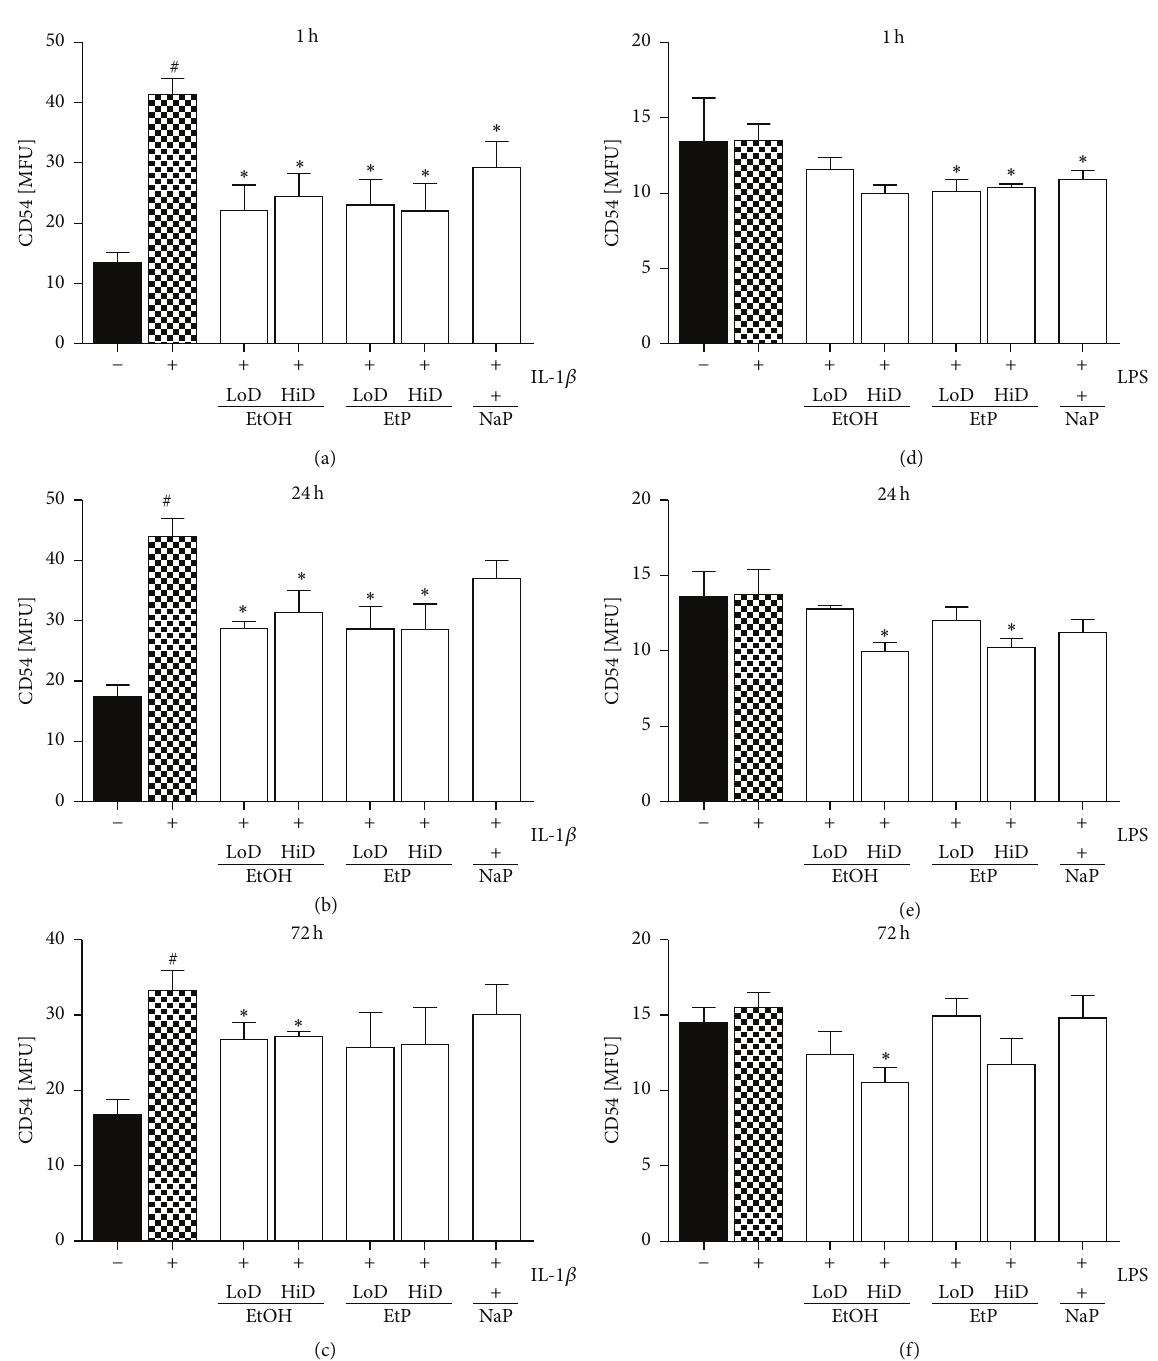
Figure 8: Effects of ethanol (EtOH), ethyl pyruvate (EtP), or sodium pyruvate (NaP) on the surface expression of CD54 in lung epithelial cells A549 after IL-1beta ((a)–(c)) or lipopolysaccharide (LPS (d)–(f)) stimulation. Cells were treated with EtOH (low dose, LoD = 85 mM and high dose, HiD = 170mM), EtP (LoD = 2.5 mM, HiD = 10mM), or NaP (10mM) for 1 h ((a) and (d)), 24h ((b) and (e)), or 72 h ((c) and (f)) and then stimulated with IL-1beta (1ng/mL) or LPS (1 𝜇 g/mL) for 24 h. After the incubation periods, CD54 expression was evaluated (given as mean fluorescence unit, MFU). The data are presented as means ± s.e.m. ∗ 𝑃 < 0.05 versus untreated but stimulated control, ctrl; # 𝑃 < 0.05 versus untreated and unstimulated